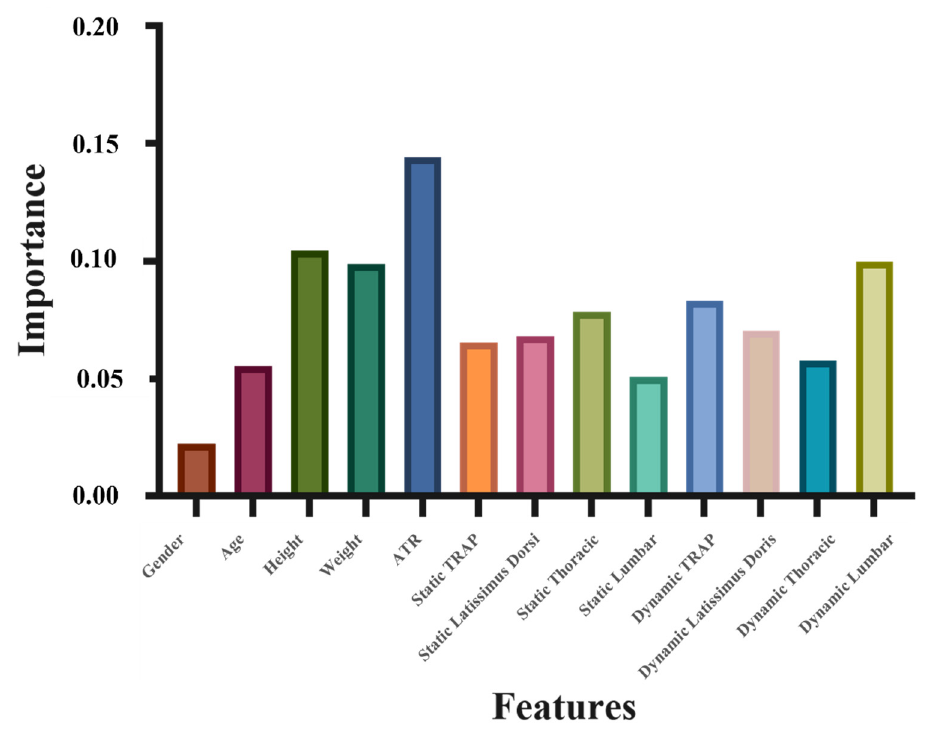
Figure 8. Importance of each feature based on random forests.